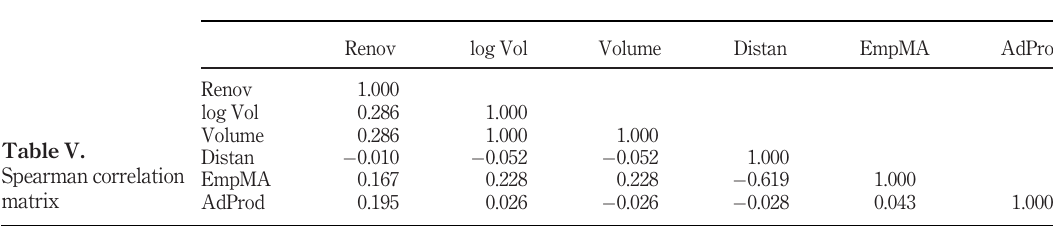
Table IV. Hypotheses, variables and expected